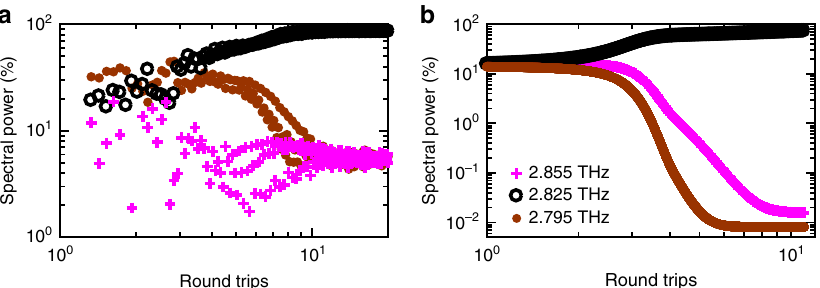
Fig. 4 Distribution of power among lasing modes as a function of cavity round-trips. The power of three modes (2.795, 2.825 and 2.855 THz) normalised to represent percentage of total emitted power: a calculated from experimental data and b simulated using the reduced rate equation model. In each case, only the three dominant modes are shown for clarity